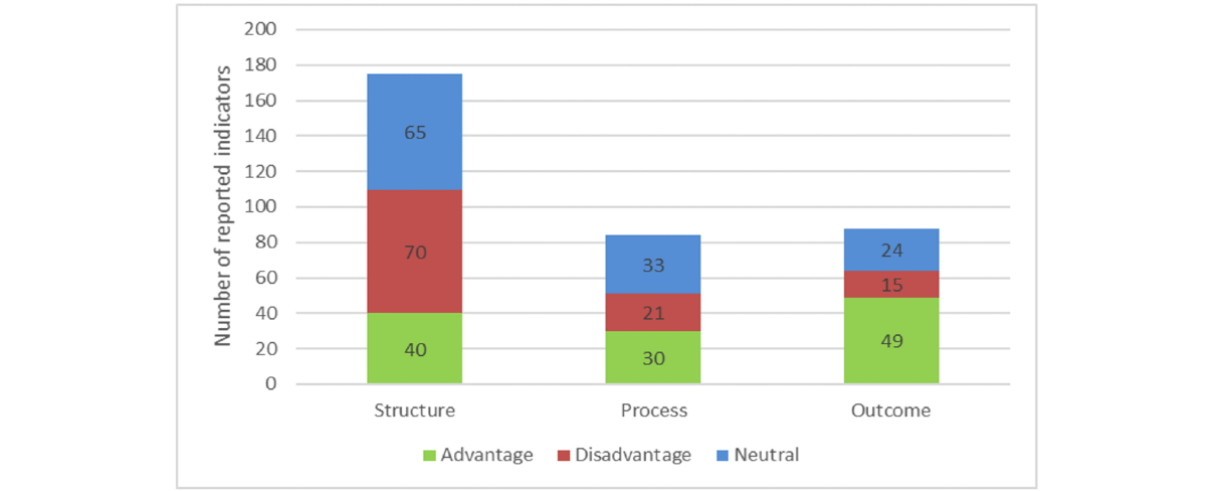
Figure 5. Number of indicators reported in the structure, process, and outcome categories. Advantage: in the structure and process categories, advantage indicates a positive effect on the integration. In the outcome category, it indicates a positive effect on the outcome. Disadvantage: in the structure and process categories, disadvantage indicates a negative effect on the integration. In the outcome category, it indicates a negative effect on the outcome. Neutral: Indicator was neither an advantage nor a